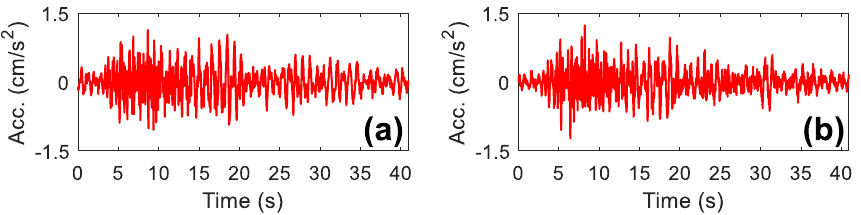
Fig. 10 Measured earthquake time histories at the tower bases of the Jiuzhou bridge: a site 3 and b site